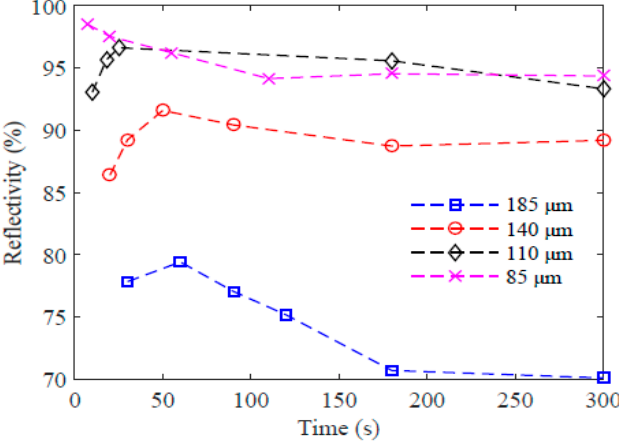
Figure 3. Reflectivity of the PFBGs with different diameters at various exposure times.